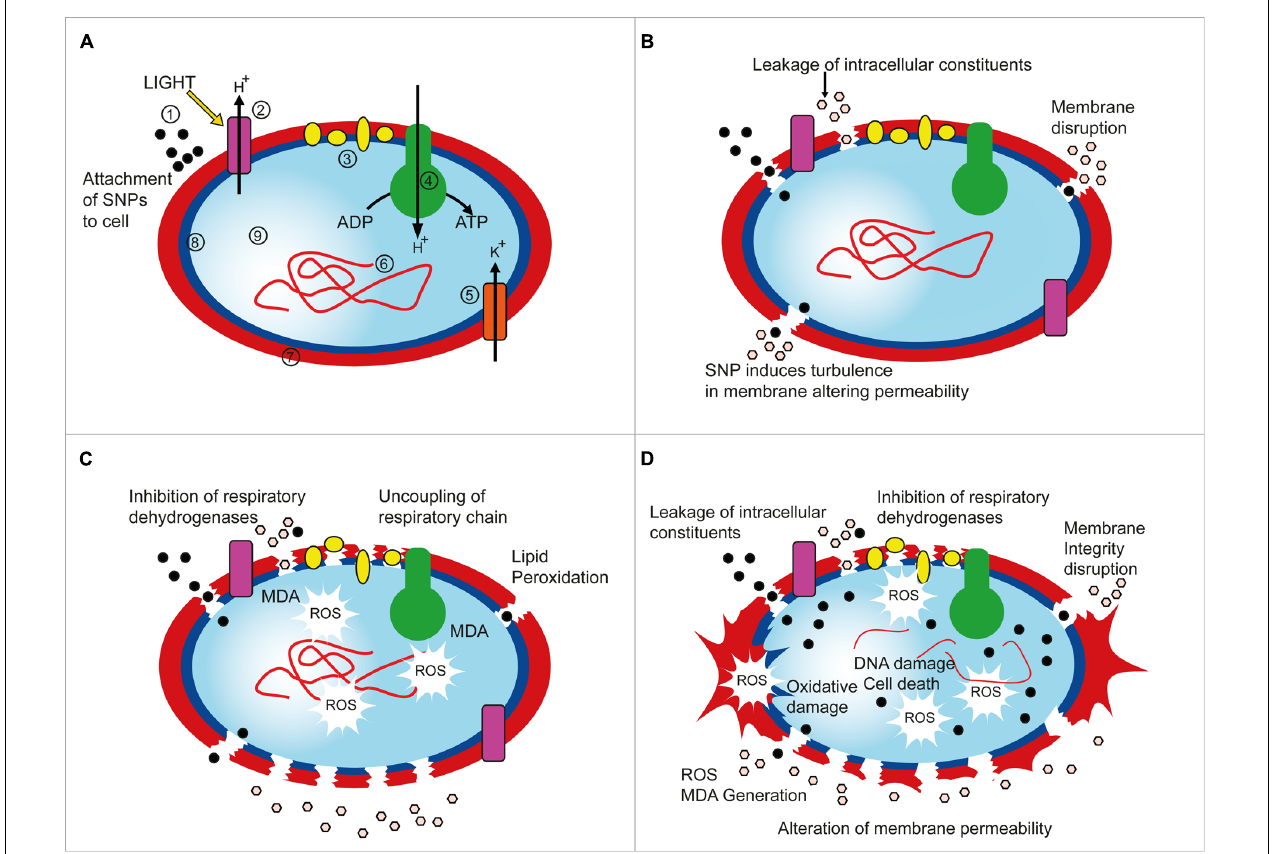
FIGURE 7 | Proposed mechanism of inhibition of haloarchaea by SNPs. (A) Attachment of SNPs to cell. [1: SNPs, 2: Bacteriorhodopsin protein, 3: Electron transport chain, 4: ATPase complex, 5: Trk type Potassium ion channel, 6: Haloarchaeal genomic DNA, 7: S-layer, 8: Membrane, 9: Intracellular cytosol]. (B) Disruption of membrane integrity and leakage of intracellular constituents. (C) Inhibition of respiratory dehydrogenases and electron transport chain and generation of MDA and ROS. (D) Oxidative, DNA and cellular damage caused by ROS leading to cell